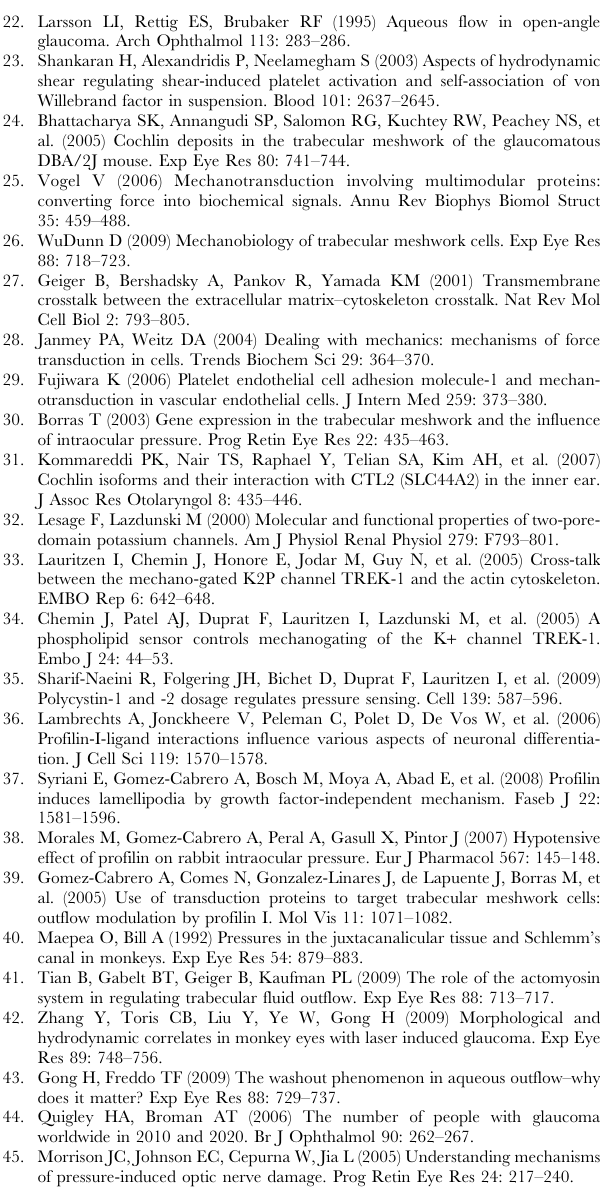
Figure S3 Cochlin multimerization in response to fluid shear. (A) Comparison of percentage of cochlin showing multi- merization when subjected to different levels of fluid shear as indicated. The purified recombinant cochlin was subjected to different flow rates 2.5–5.0 m l/min for 50–200 cycles as indicated. Densitometric scan from four independent experiments were used to calculate mean 6 standard deviation, which has been presented here. (B) A representative Western blot analyses of control [not subjected to shear stress (*); as indicated] and cochlin subjected to shear stress as indicated. The purified cochlin was subjected to flow rates of 2.5–5.0 m l/min as indicated for 50–200 cycles as indicated.